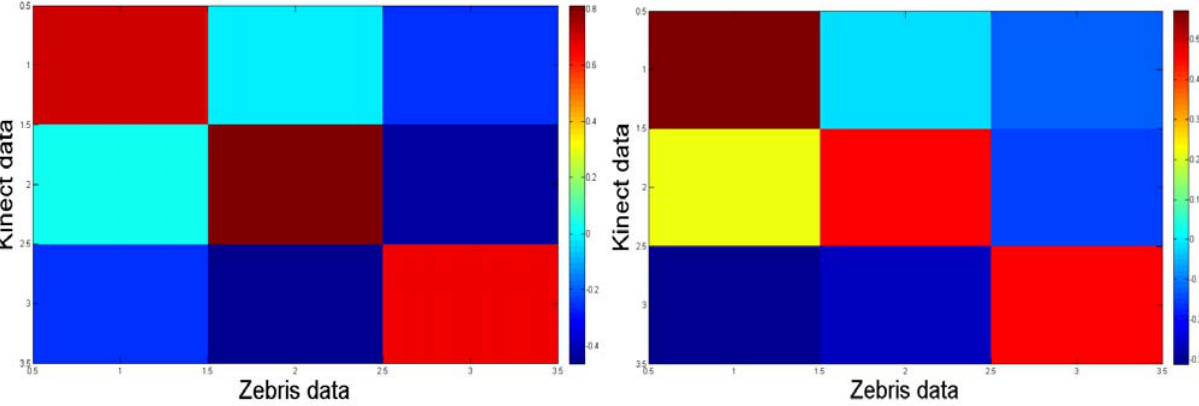
Figure 8. Correlation map between axes for the control participant (left panel) and the apraxic participant (right